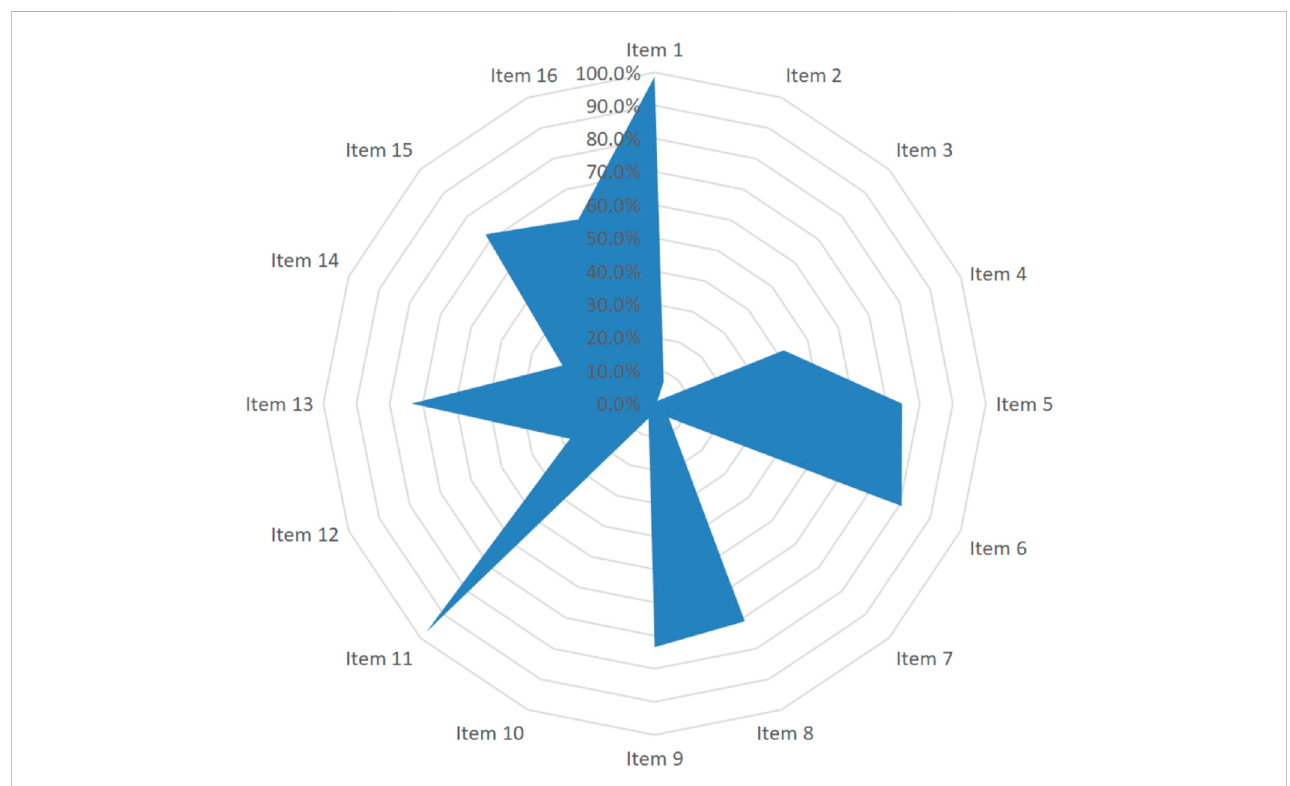
Methodological quality of systematic reviews based on AMSTAR-2.